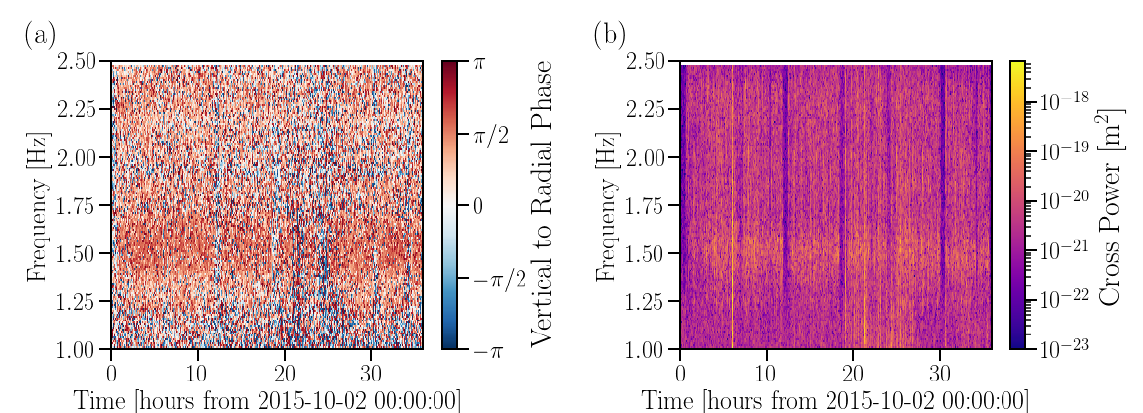
Figure 6. ( a ) Vertical-to-horizontal phase between the east and the vertical channels of the YATES station is shown for 36 h starting from 2 October 2015. ( b ) Cross-power between the vertical and east channels of YATES station. The signal at 1.4–1.6 Hz appears at the 1 h mark, and its phase hovers near π /2 radians, consistent with the retrograde motion in Rayleigh waves. This signal is clearly a peak in the spectrum, as seen on the